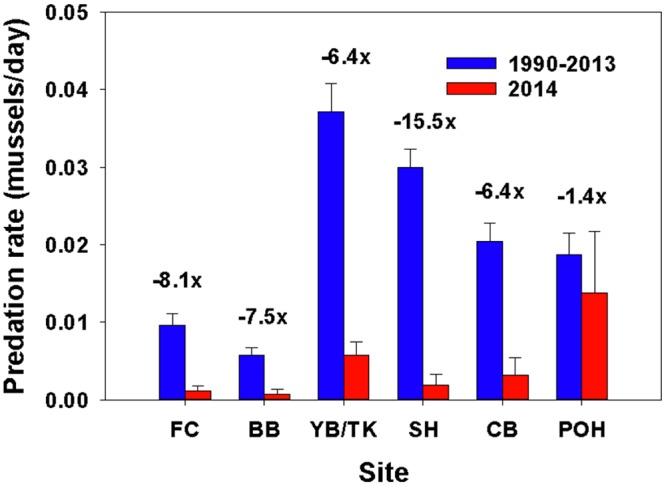
Comparison of predation rate on mussels, Mytilus californianus, in summer 2014 compared to rates averaged across 1990–2013 at six sites.Numbers above each pair of bars show the magnitude of decrease in predation rate.